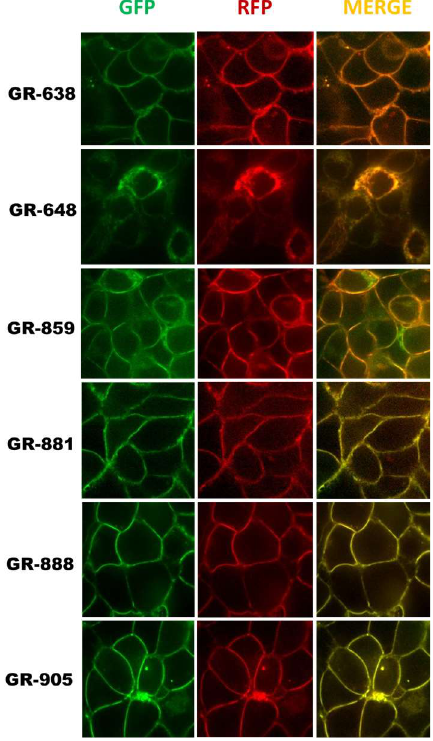
Figure 3. Localization and expression of two-color MRP1 proteins. HEK-293 (human embryonic kidney) cells were plated on glass-bottom chambered coverslips as described in Section 2.8. Fluorescent images were taken using a confocal microscope equipped with a 63× oil-immersion objective. GFP and TagRFP were excited at 470 nm and 561 nm, respectively. Emission was collected at 480–530 nm for GFP and 580–669 nm for RFP.